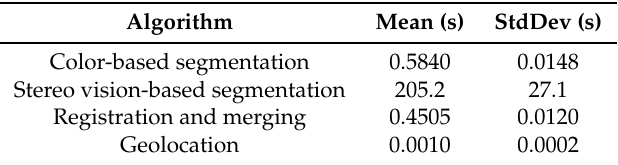
Table 5. Execution time of the proposed algorithms on the RaspberryPi 3. Mean and standard deviation per image. Time is in